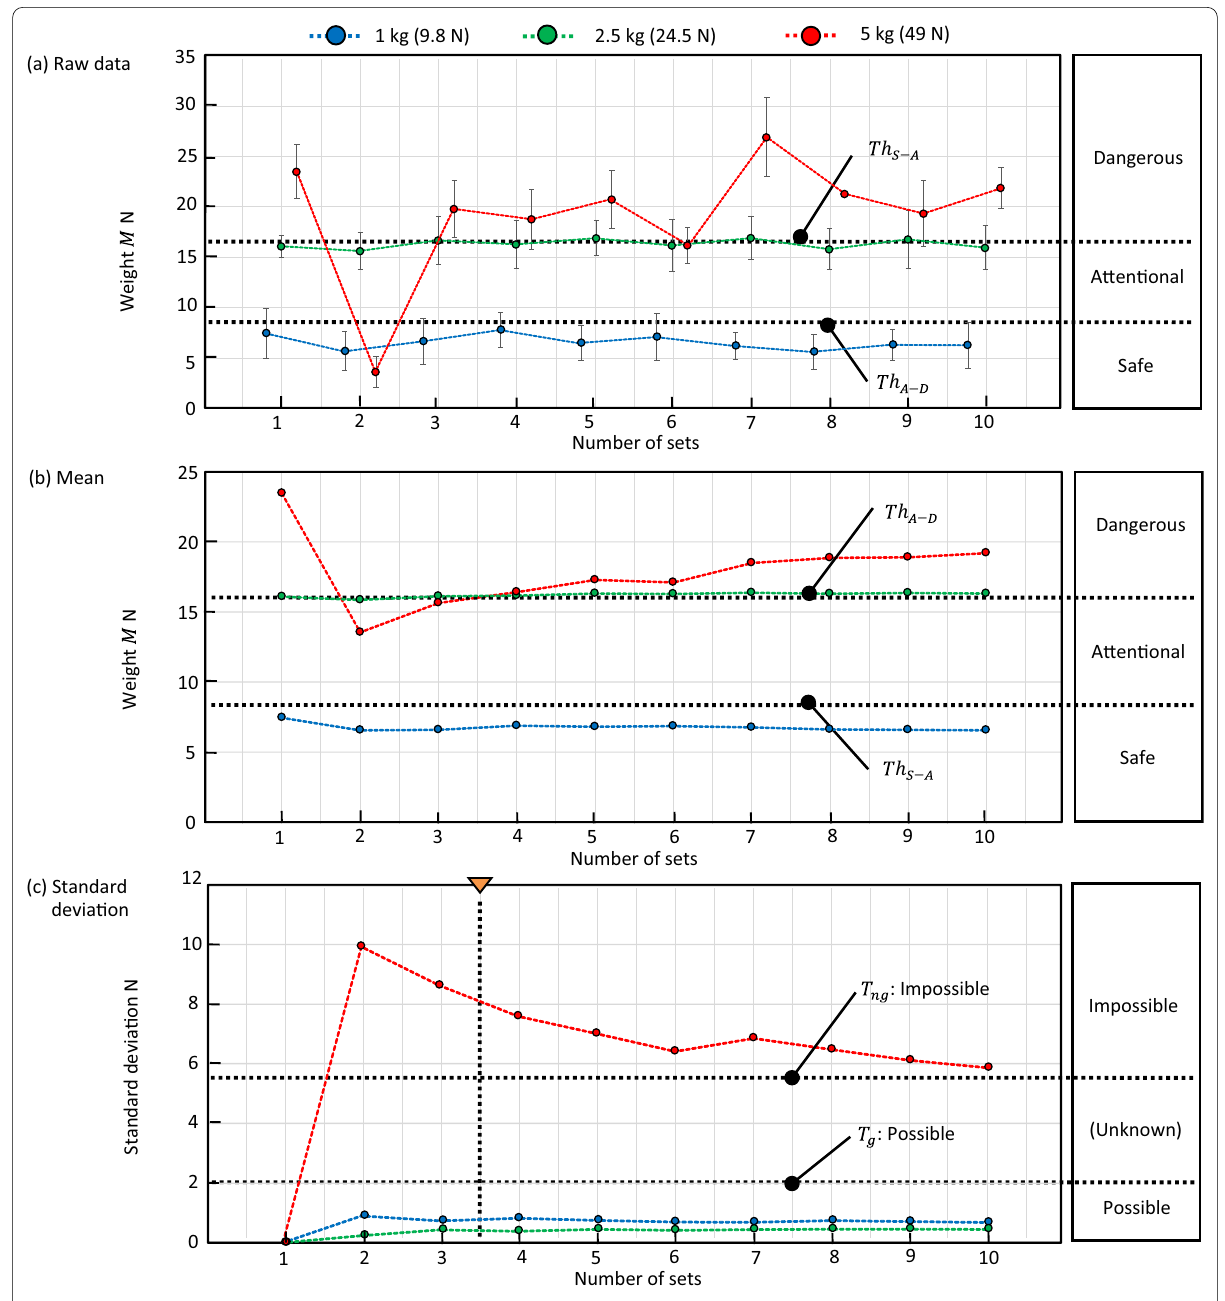
Fig. 11 Estimated weight and accident